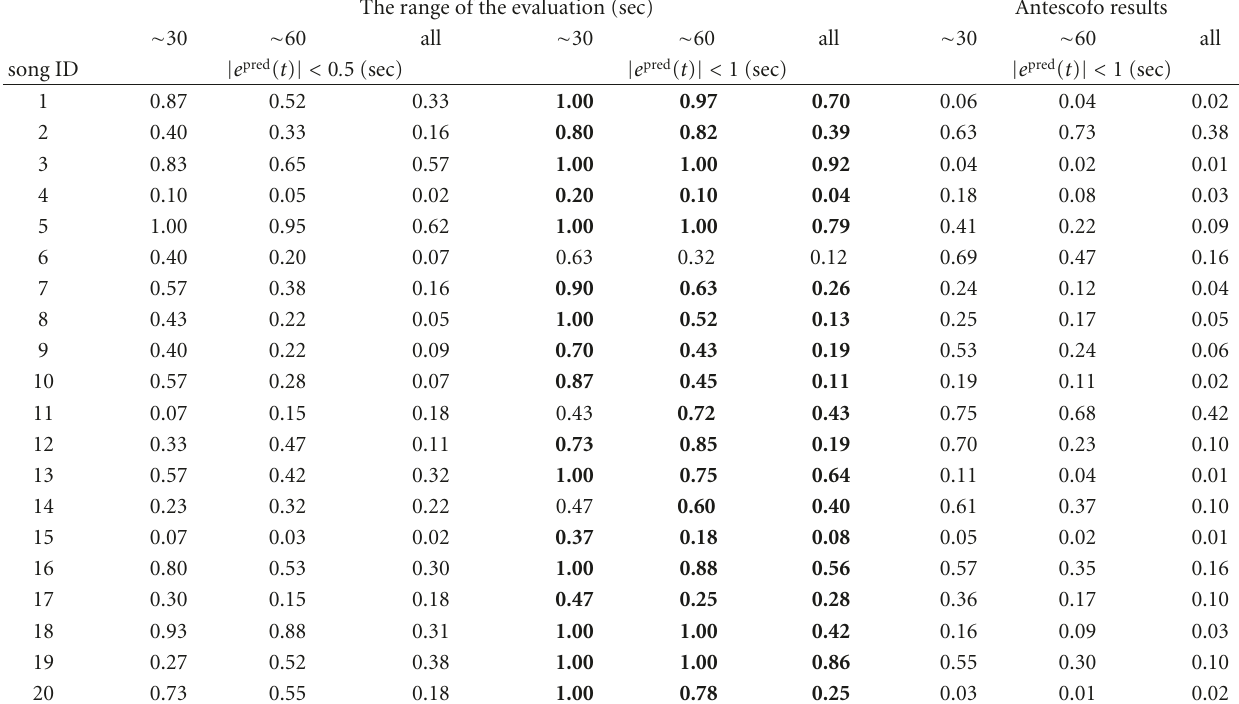
Table 3: Score following error ratio w/o level switching.